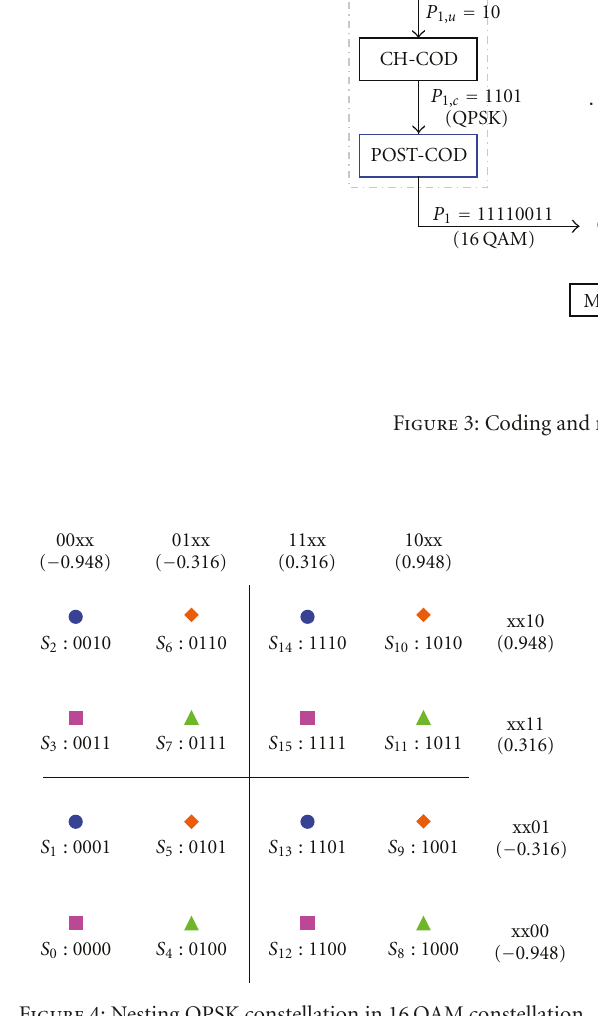
Figure 4: Nesting QPSK constellation in 16 QAM constellation.